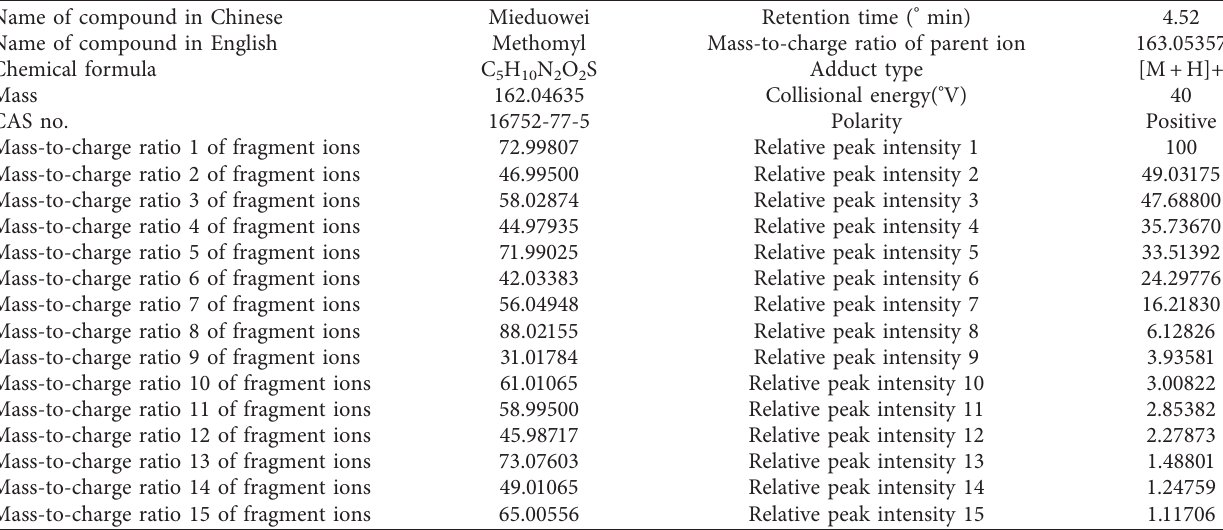
Table 1: Content of a high-resolution spectrum library